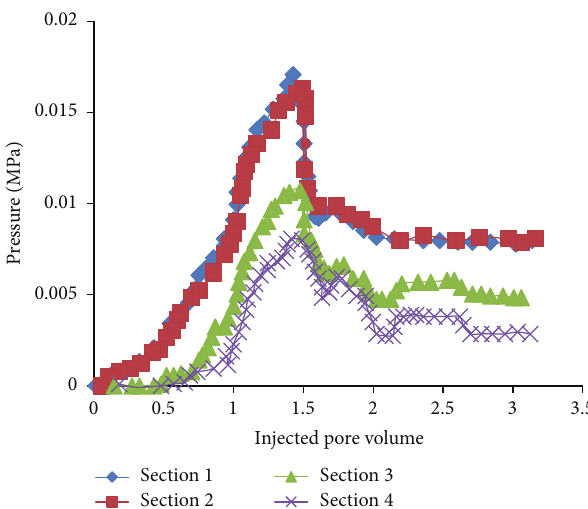
Figure 10: The plot of the injection pressure (diameter: 0.02 mm, concentration: 3000 mg/L).